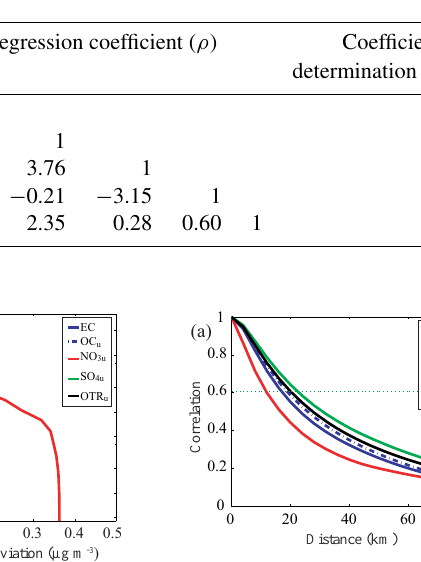
Table 1. Regression coefficients of balance operator K and the coefficient of determination (regression coefficients correspond to ρ ij in Eq. 7).